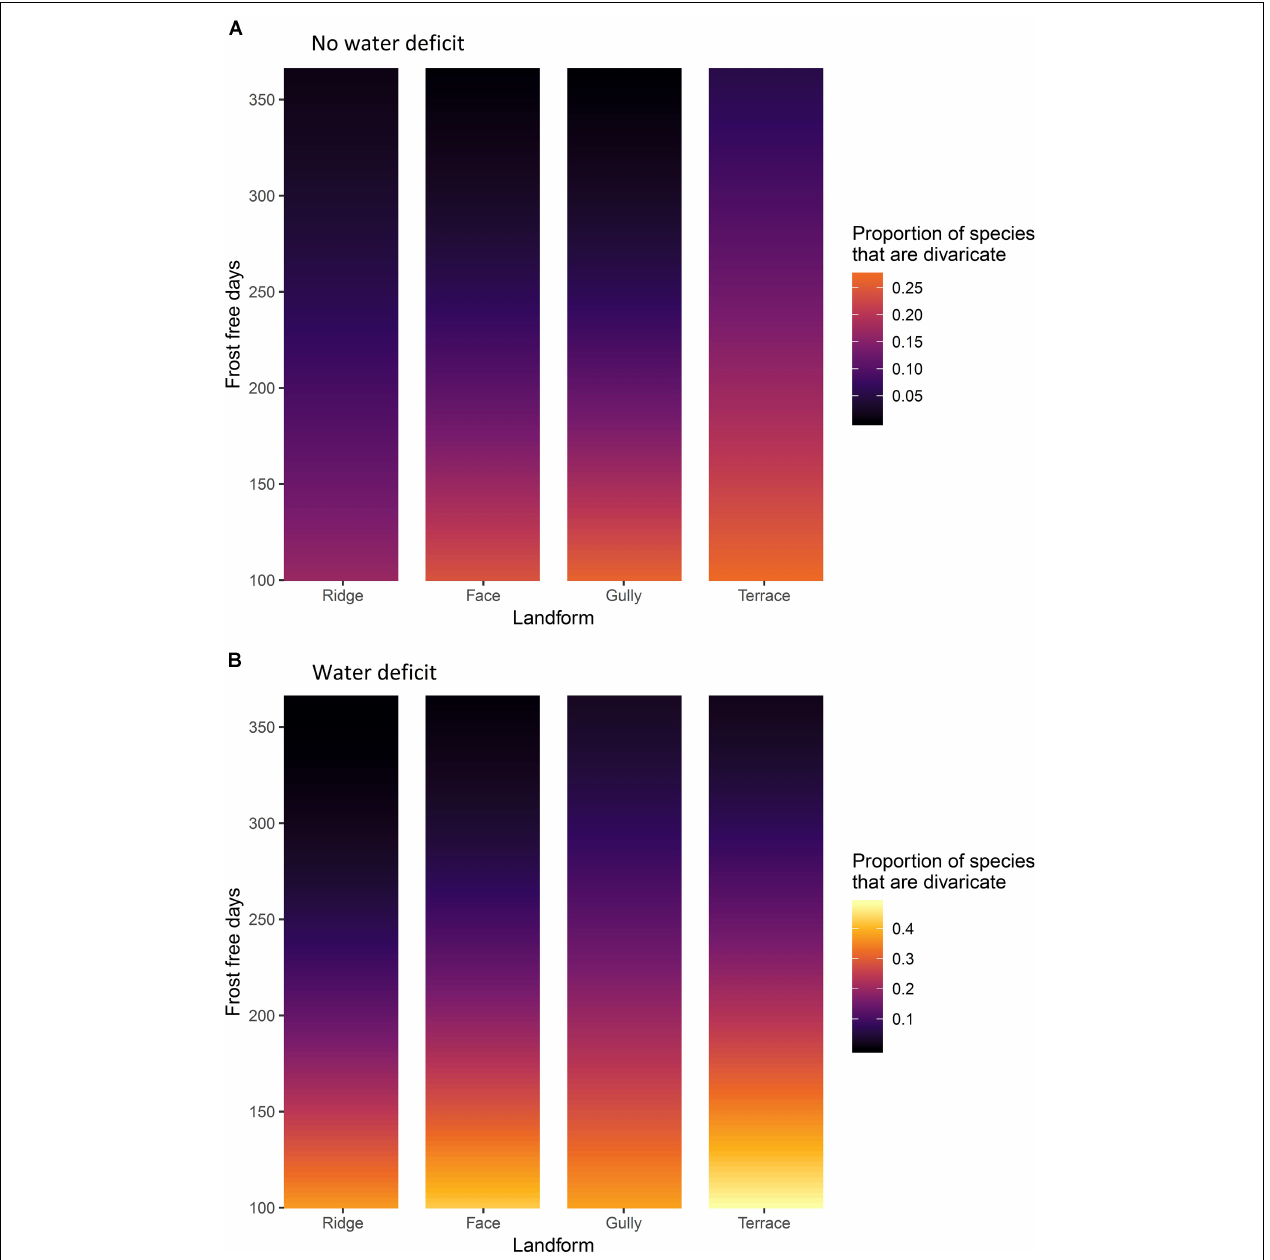
FIGURE 5 | (A) Sites without water deficit, i.e. precipitation exceeds evapotranspiration in all months of the year. (B) sites with an annual water deficit, i.e. where evapotranspiration exceeds precipitation during some months. The effects of frost-free period and topographic position on representation of divaricate species in arborescent assemblages on 9,601 relevé forest plots in New Zealand. Yellow = high representation of divaricate species, black = low